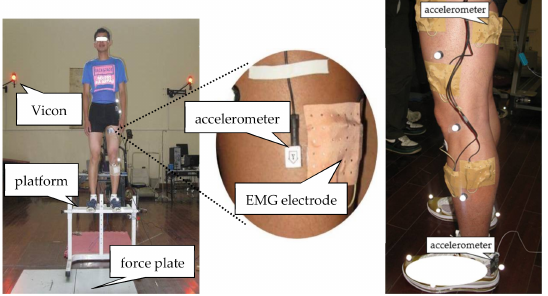
Figure 2. Experimental setup and placements of the accelerometer and electromyography (EMG) electrodes. Sagittal plane kinematic data of the dominant leg, defined by the preferred kicking leg [19], were acquired by using an eight-camera infrared 3D motion capture system (Vicon MX, Oxford Metrics, UK) at a sampling rate of 120 Hz with a plug-in gait marker set [17]. The hip, knee, and ankle were defined by twenty-eight retroreflective markers attached to the lower body. Two 90 cm × 60 cm force plates (9287B, Kistler Corporation, Winterthur, Switzerland) laid flat on the surrounding floor were used at 1200 Hz to capture the ground reaction force (GRF). Kinematic data and the GRF were simultaneously collected with the Vicon